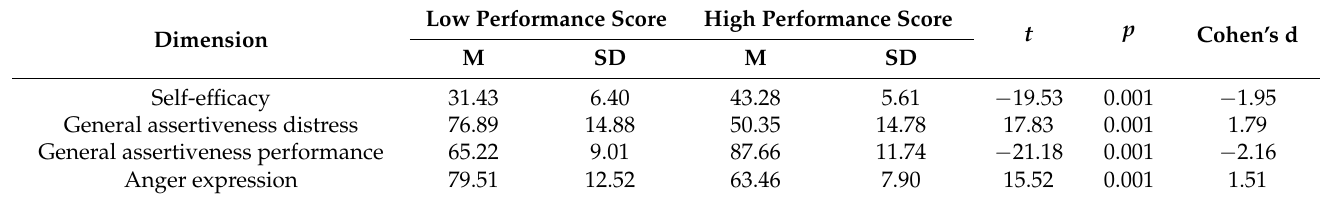
Table 2. Performance score differences in the dimensions of the study. (Student’s t -test, p < 0.05).